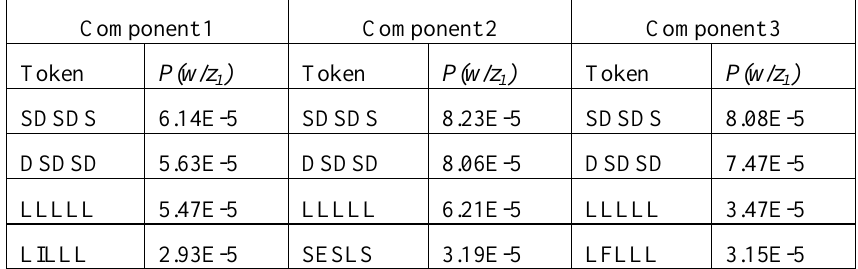
Tab. 3: The five most highly-ranked tokens in each component Component 1 Component